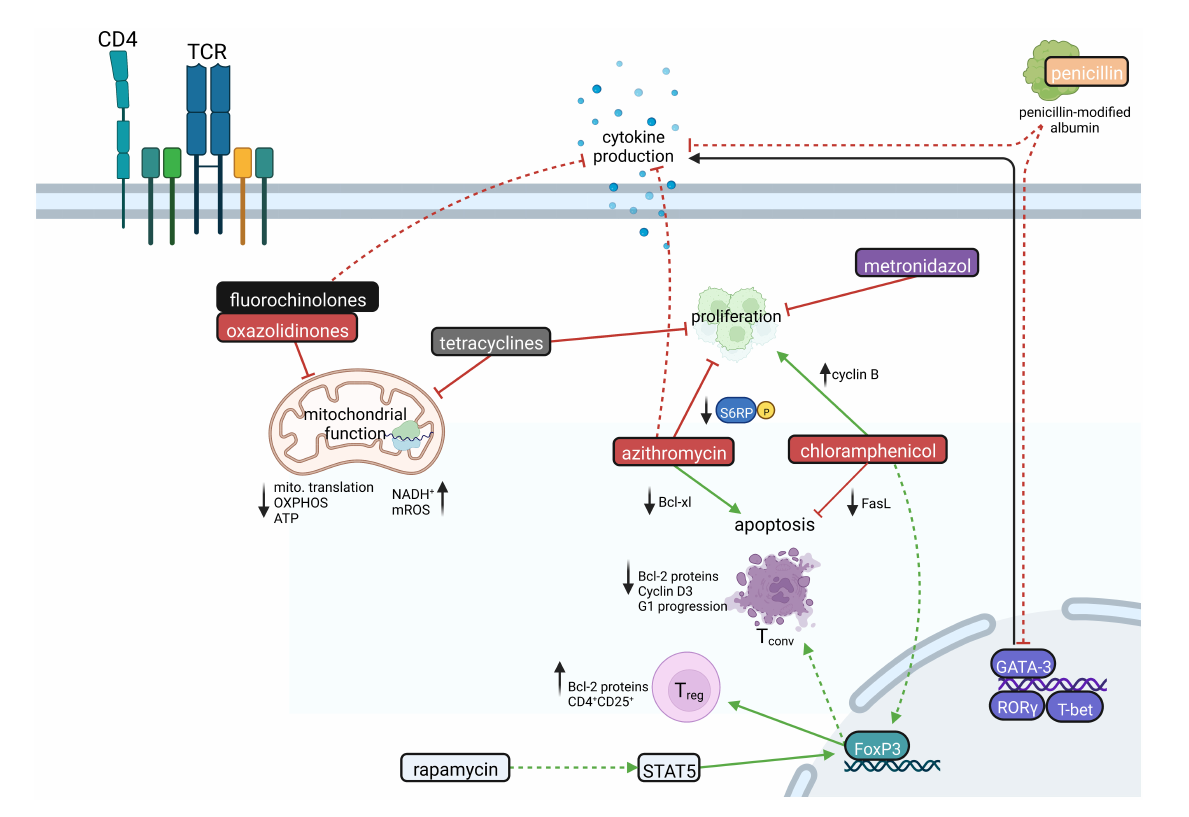
FIGURE2 The influence of antibiotics on CD4 + T cells. CD4 + T cell proliferation is inhibited by tetracycline, azithromycin, and metronidazole. Chloramphenicol, in turn, forces proliferation by increasing cyclin B expression. Azithromycin, favoring the downregulation of the antiapoptotic Bcl-xl protein, increases CD4 + T cell apoptosis, whereas chloramphenicol hampers apoptosis by downregulating Fas ligand. Antibiotics like fluorochinolones, tetracyclines, and oxazolidinones inhibit mitochondrial function leading to decreased mitochondrial translation and ATP production via OXPHOS and increased levels of NADH + and mitochondrial reactive oxygen species (mROS). Moreover, antibiotics influence important transcription factors in various ways. GATA-3 is downregulated by penicillin, while chloramphenicol treatment leads to FoxP3 upregulation. Rapamycin likewise induces the upregulation of FoxP3, which promotes the generation of CD4 + CD25 + regulatory T cells (T reg ) while conventional T cells (T conv ) are driven to apoptosis. Moreover, fluorochinolones, azithromycin, and penicillin could lead to decreased production of CD4 + T cell effector cytokines. Created with